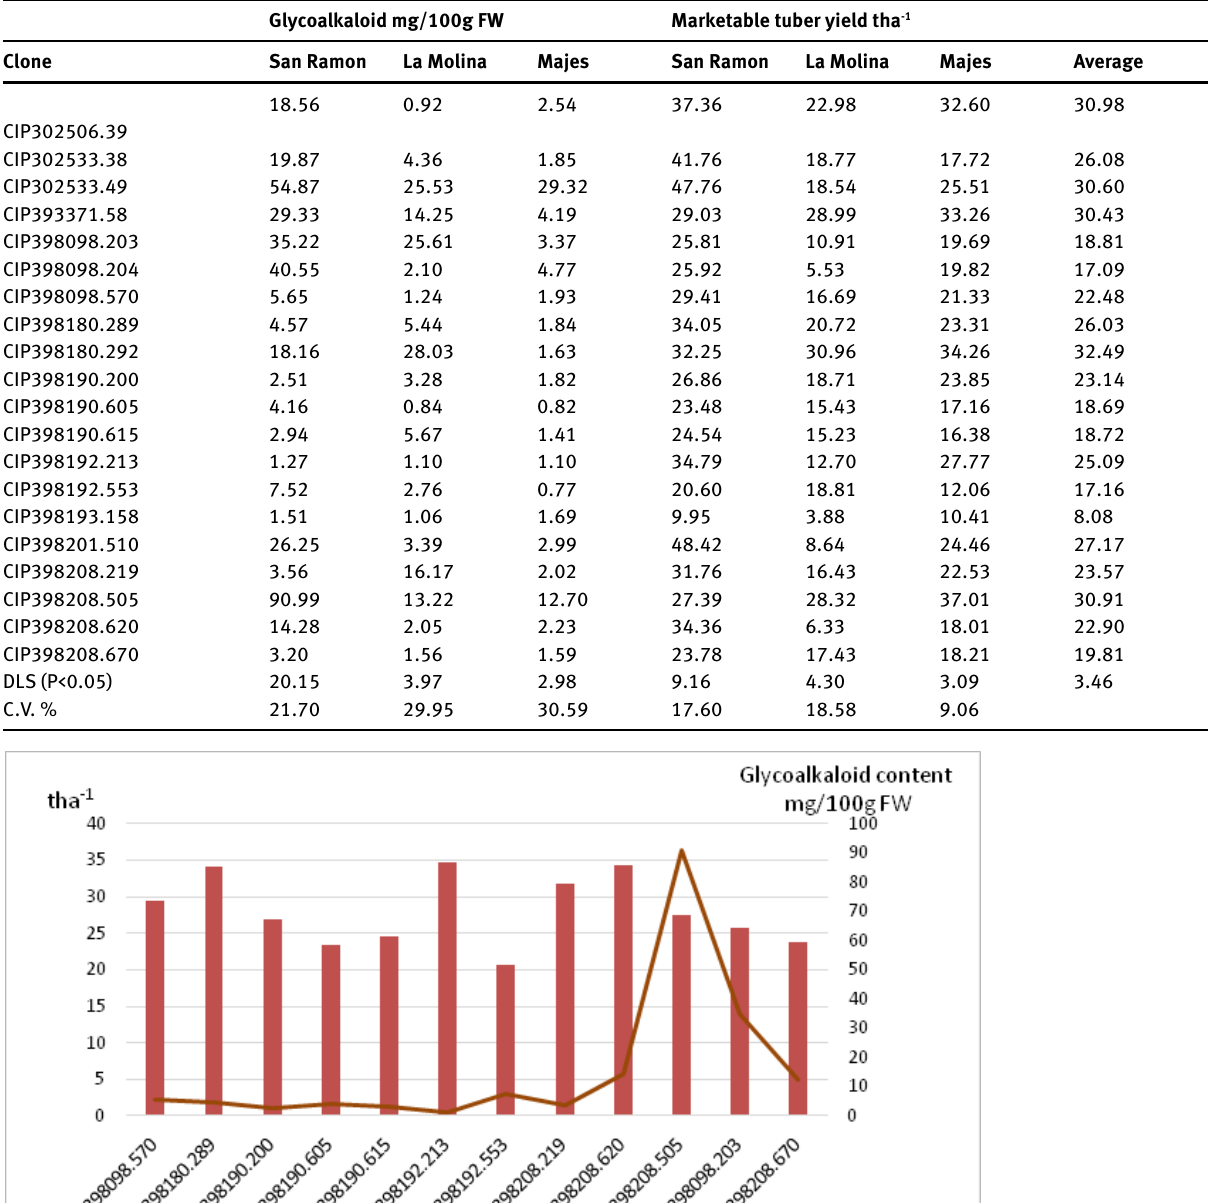
Table 9: Marketable tuber yield and glycoalkaloid content in 20 LBHT clones under warm environments. 2014- 2015 Glycoalkaloid mg/100g FW